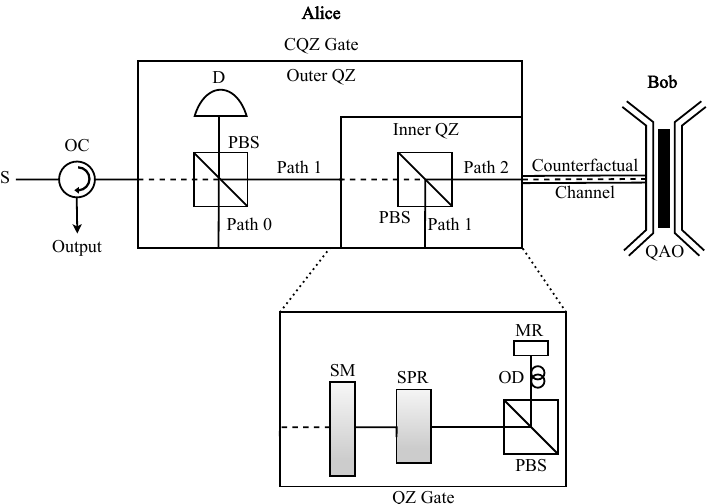
Figure 1. Chained quantum Zeno (CQZ) gate. It is a nested version of the quantum Zeno (QZ) gate where Alice inputs a source photon (S), which can be an H- or V-polarized photon. It is made up of a set of optical devices, including switchable mirrors (MR), switchable polarization rotators (SPR), polarizing beam splitters (PBS), optical delays (OD), mirrors (MR), optical circulator (OC), and detectors (D). Once the photon enters into the CQZ gate, it gets collapsed into three different paths, namely path 0, path 1, and path 2, due to the SPRs and PBSs in the outer and inner QZ gates. Only the photon component in path 2 enters into the quantum channel. Bob, who is on the other side of the quantum channel, holds a quantum absorptive object (QAO), which is a superposition of absence and presence states of absorptive object (AO). He decides whether to absorb or not that photon component by inserting or not inserting AO. For a complete CQZ gate operation, the photon experiences M cycles of the outer QZ gate where each outer cycle consists of N cycles of the inner QZ gate. The logical operation of the CQZ gate is that it retains (rotates) the polarization of the incoming source photon in the absence (presence) of